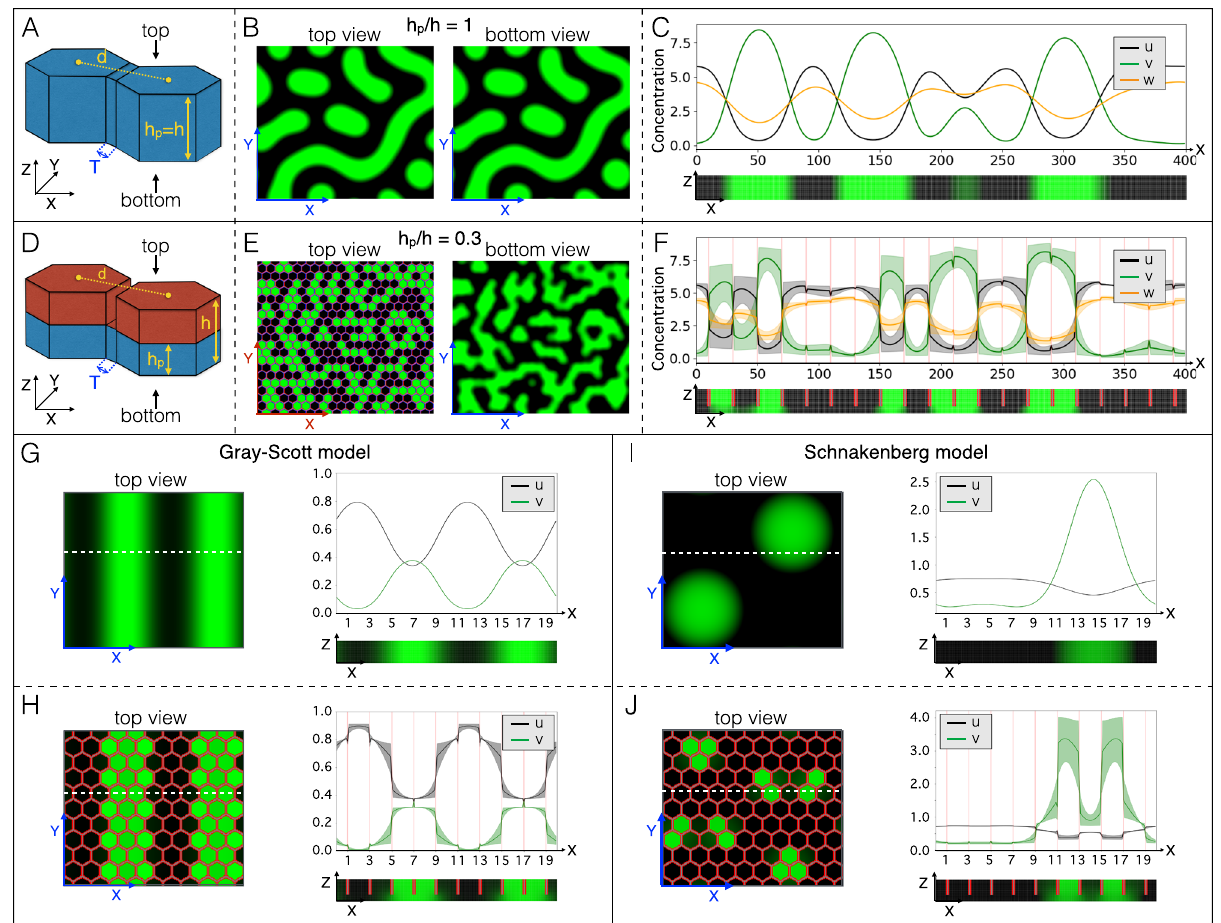
Fig. 2 Geometry transforms continuous RD into discretised systems. A – C When the domain does not exhibit variation of thickness ( A ), the steady-state RD pattern does not vary between top and bottom views of the simulated skin ( B ), and the concentrations of RD components show continuous spatial variation ( C ; concentration pro fi le at y = 0 averaged across z) and no variation in the z direction (bottom panel in C ). D – F When the domain thickness is substantially smaller (hp) in between (T) than within (h) prisms ( D ; h p/ h = 0.3), a prism-by-prism coloration emerges ( E ) with sharp transitions of concentrations of RD components at prisms ’ borders ( F ; average concentrations at y = 0; shaded regions are minimum-maximum concentration intervals in the z direction). Broader gradients at borders of prisms in bottom view (see also bottom panel of F ) are due to unconstrained diffusion in the basal part of the simulation domain. G – J Variation of domain thickness ( h p/ h = 0.3 in H and J ) also transforms simpler two-component continuous RD models into discrete systems ( H , J ). Pro fi les of average concentrations (at the y coordinate indicated by the white dotted lines) are shown; shades in ( H , J ) are minimum-maximum concentration intervals in the z